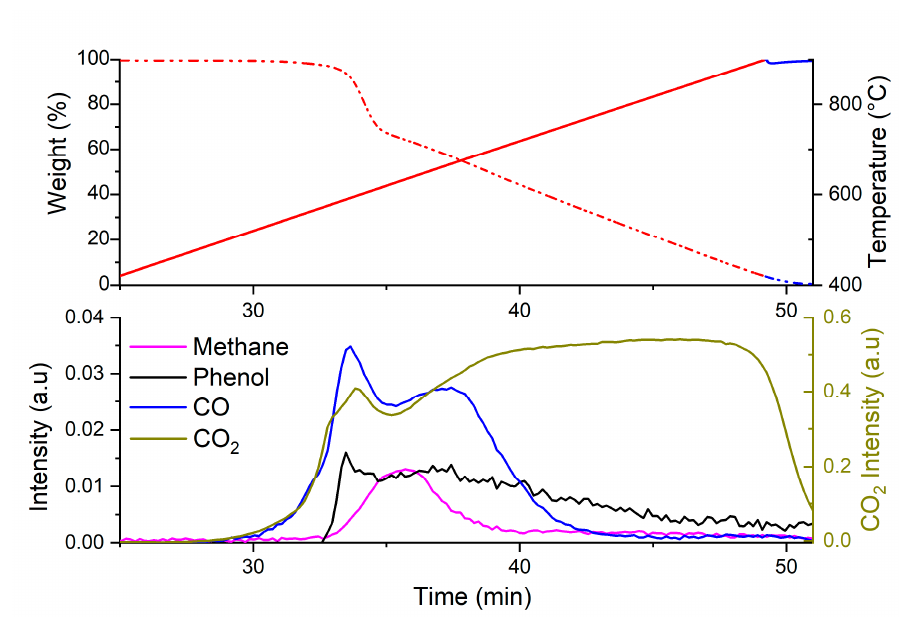
Figure 8. ( top ) TGA plot of PEEK in synthetic air at a heating rate of 20 °C/min and ( bottom ) peak intensity profiles corresponding to gases evolved during the TGA measurement.